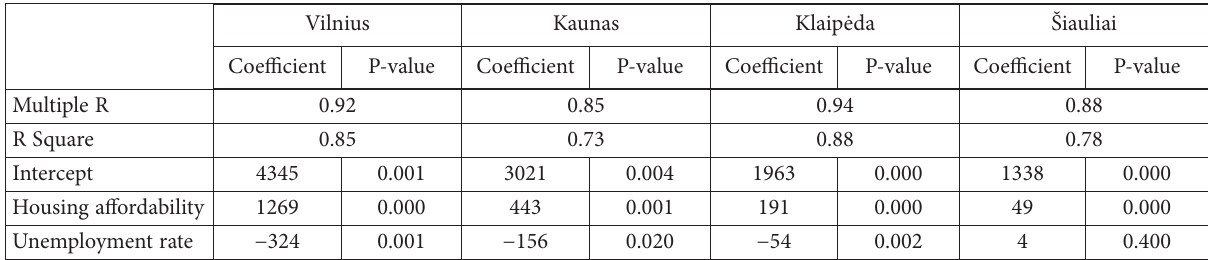
Table 10. Linear multiple regression